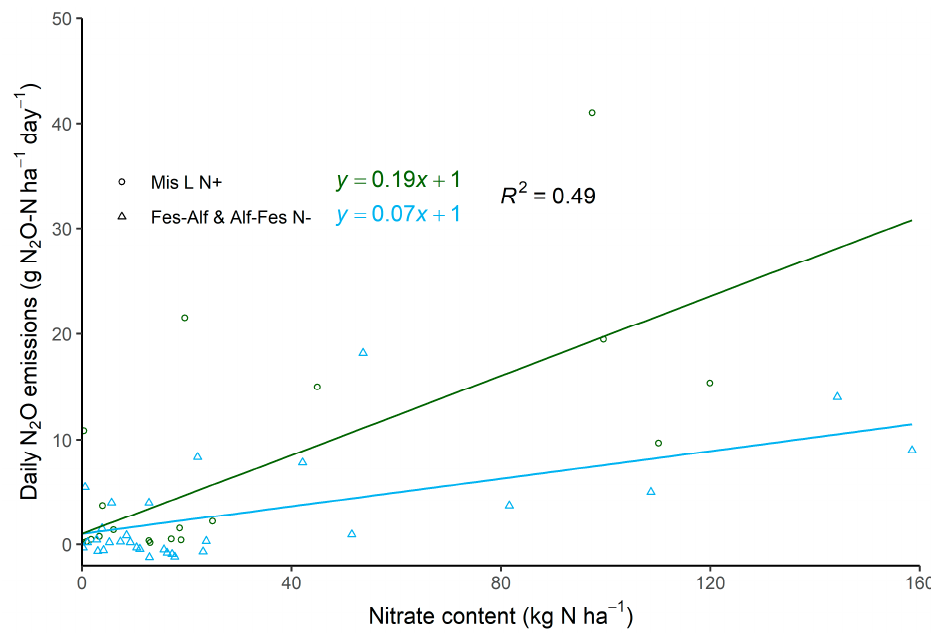
Figure 9. Relationship between daily N 2 O emissions and soil nitrate content (0–30 cm) for Mis L N+ (dark green line) and Fes-Alf and Alf-Fes N − (light blue line). Lines are linear regressions. See Table 1 for treatment abbreviations.